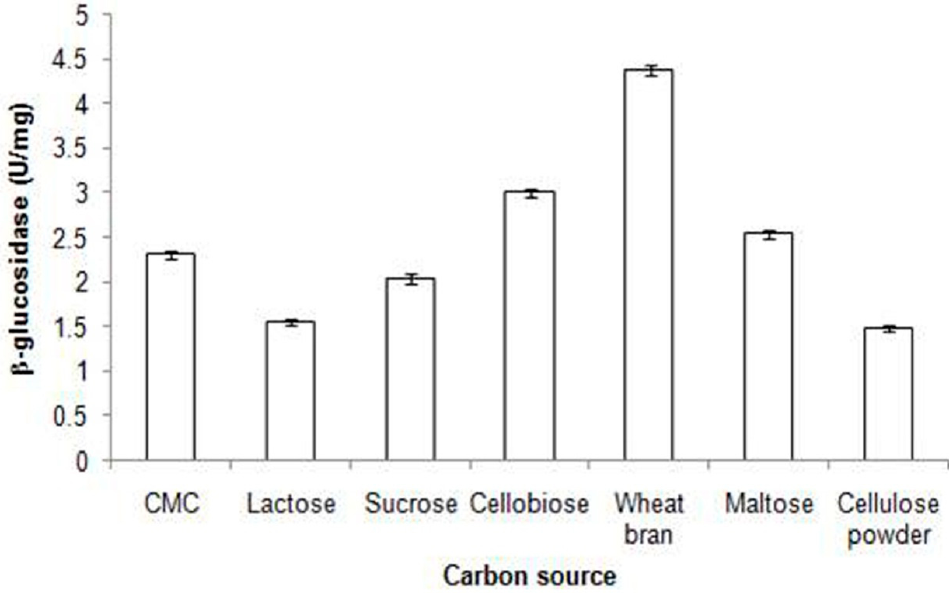
Figure 4. Different carbon sources on β -glucosidase production by A. niger NRRL 599 in shake flasks. ± indicates the standard deviation among the three parallel replicates. Incubation at 30°C for 96 h at pH 5.5 in M-I medium (adopted from the literature [73]).